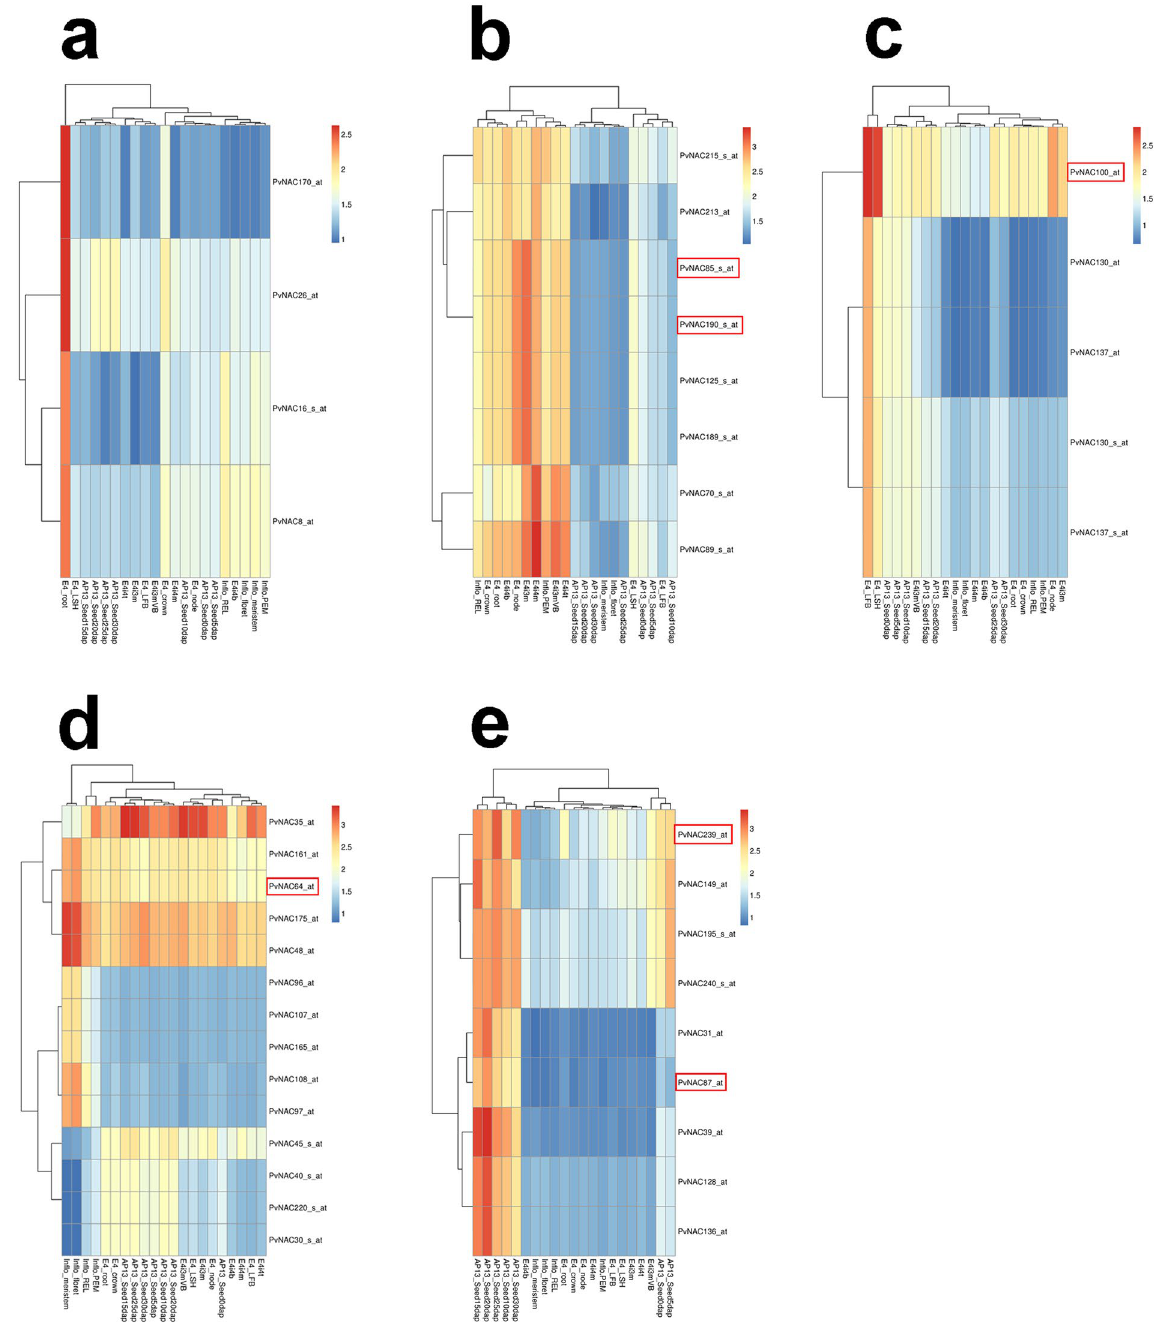
Figure 4. The special expression profiles for several tissues of PvNAC s. ( a–e ) Special expression patterns of PvNAC s in root, lignified, leave, flower, and seed tissues. AP13_ Seed0d, AP13_ Seed5d, AP13_ Seed10d, AP13_ Seed15d, AP13_ Seed20d, AP13_ Seed25d, AP13_ Seed30d represent whole flowers at anthesis stage, whole seeds 5 days post fertilization, whole seeds with visible caryopsis, whole seeds at the milk stage, whole seeds at the soft dough stage, whole seeds at the hard dough stage, whole seeds at the physiological maturity stage, respectively. Inflo-meristem: Inflorescence meristem (0.5–3.0 mm). Inflo-floret: Floret of inflorescence when glumes are 10–20 mm. Inflo-REL: Rachis and branch elongation of inflorescence (50–150 mm). Inflo- PEM: Panicle emergence of inflorescence ( > 200 mm). E4-LFB: Pooled leaf blade from plant. E4-LSH: Pooled leaf sheath. E4i3m: Middle 1/5 fragment of the 3rd internode. E4i3mVB: Vascular bundle isolated from 1/5 fragment of the 3rd internode. E4i4b: Bottom 1/5 fragment of the 4th internode. E4i4t: Top 1/5 fragment of the 4th internode. E4i4m: Middle 1/5 fragment of the 4th internode 4. E4-root: Whole root system. E4-crown: Whole crown. E4-node: Pooled nodes. The genes with red frames were chosen for qRT-PCR in further